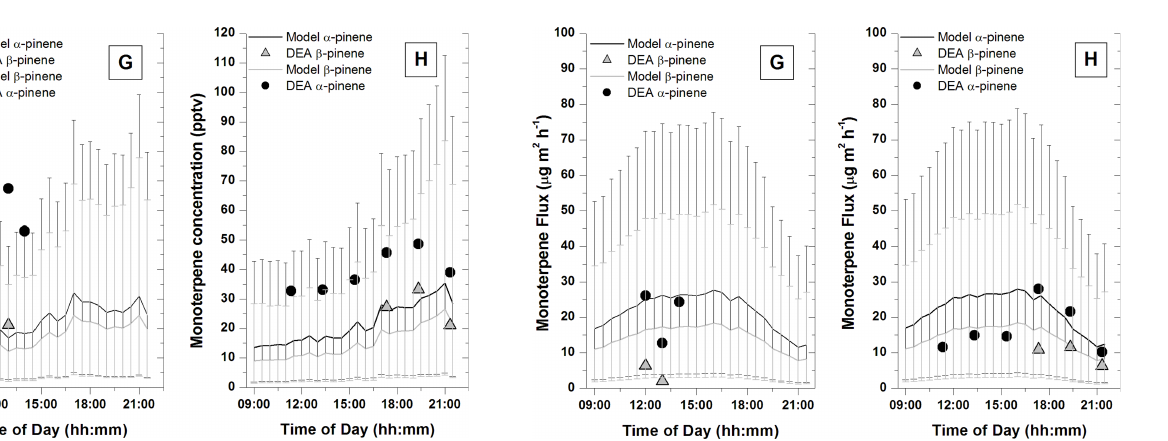
Fig. 10. Comparison of pinene and β -pinene fluxes to a 1-D atmospheric chemistry model. Again, fluxes of pinene and β - pinene compare well with the DEA measurements and are signif- icantly within the relatively large uncertainties associated with this emission-based